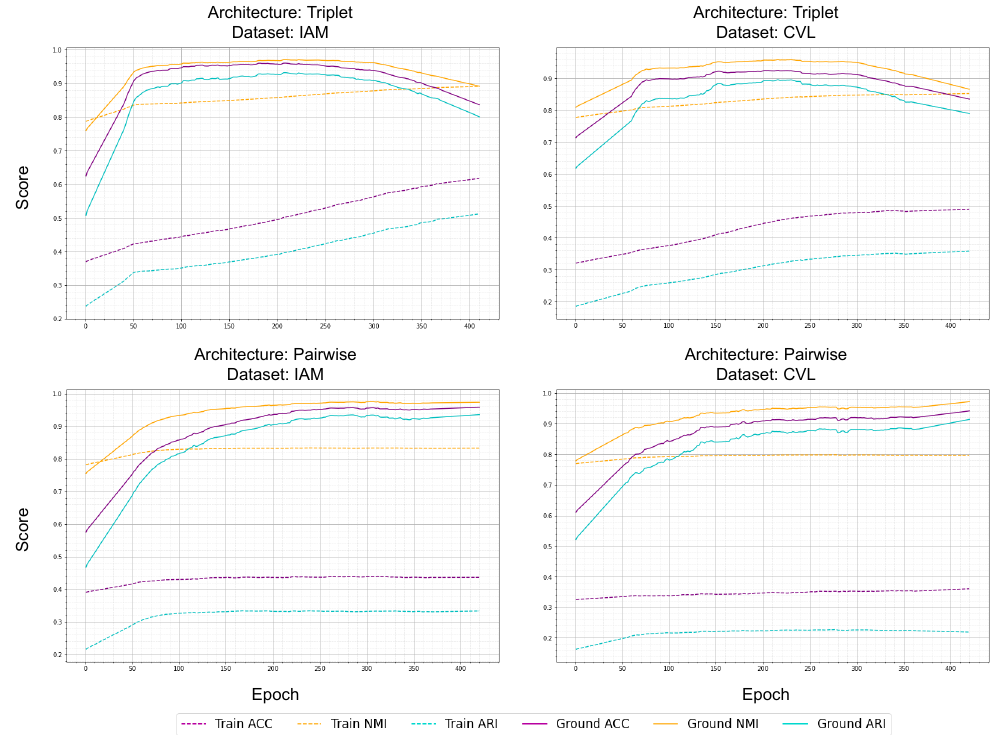
Figure 7. Graphs illustrating the metrics of pretext task and ground dataset containing 50 writers with the purity of 0. The first row represents the triplet network and the second row represents the pairwise network, respectively.